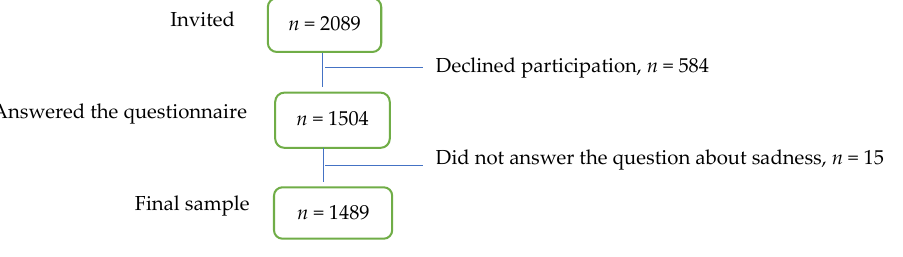
Figure 1. Flow-chart for the selection process of the study participants.